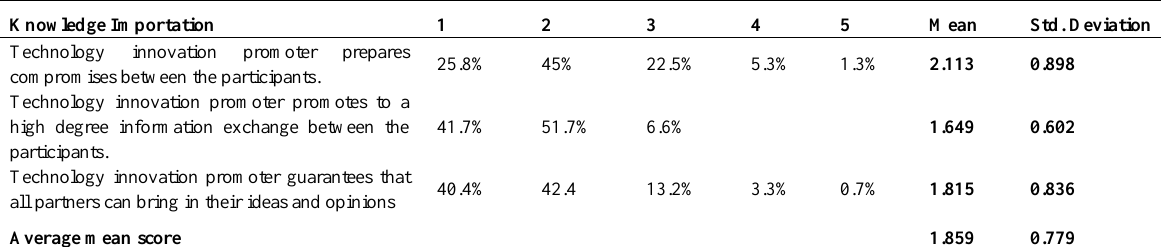
Table 4: Knowledge Importation Descriptive